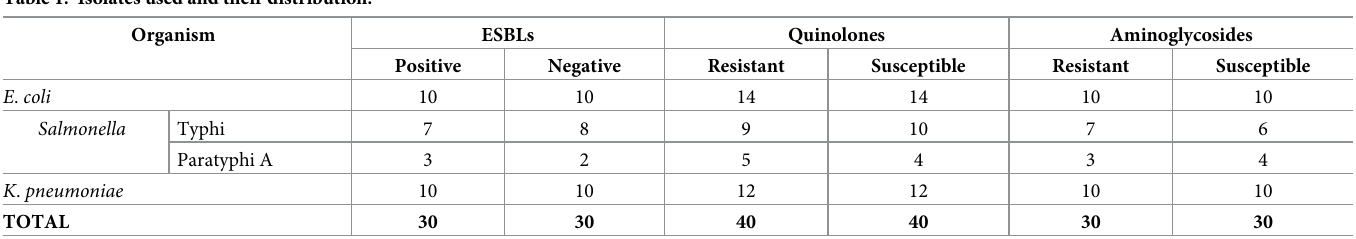
Table 1. Isolates used and their